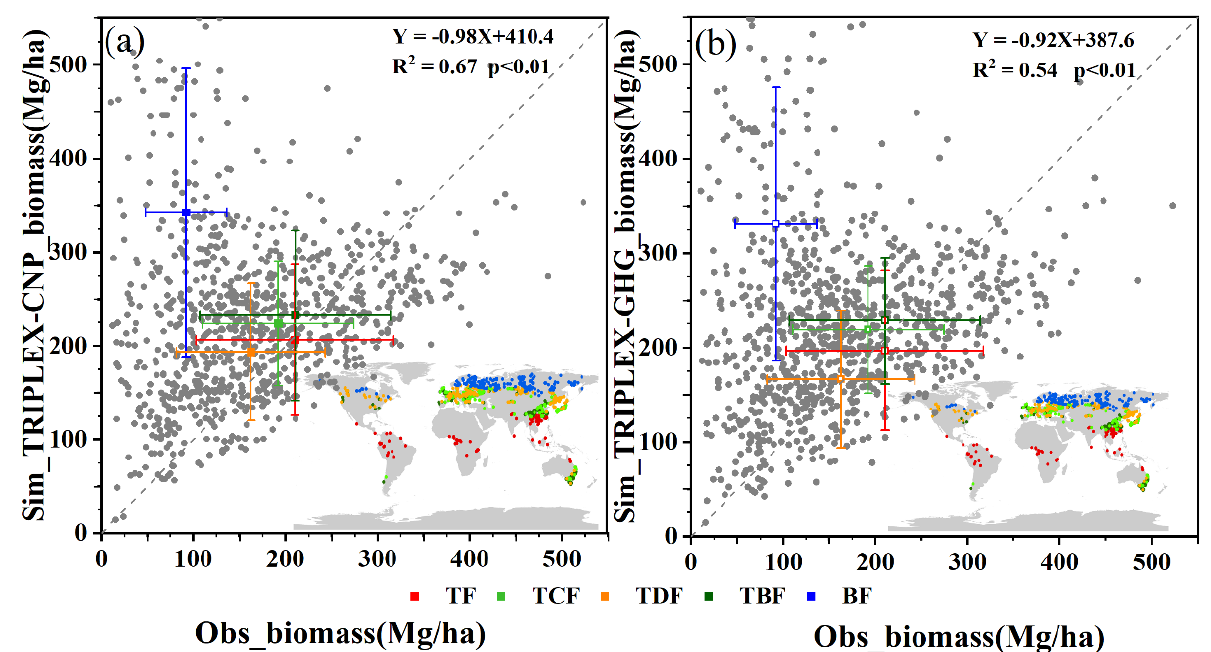
Figure 4. Comparisons of total biomass simulated by TRPLEX-CNP ( a ) and TRPLEX-GHG without phosphorus cycle ( b ) and observations. The gray points show 933 sites in global. Squares are colored according to biome, as defined in the legend to Figure 3. TF is tropical forests, TCF is temperature evergreen conifer forests; TBF is temperature evergreen broadleaf forests, TDF is temperature deciduous forests and BF is boreal forests.